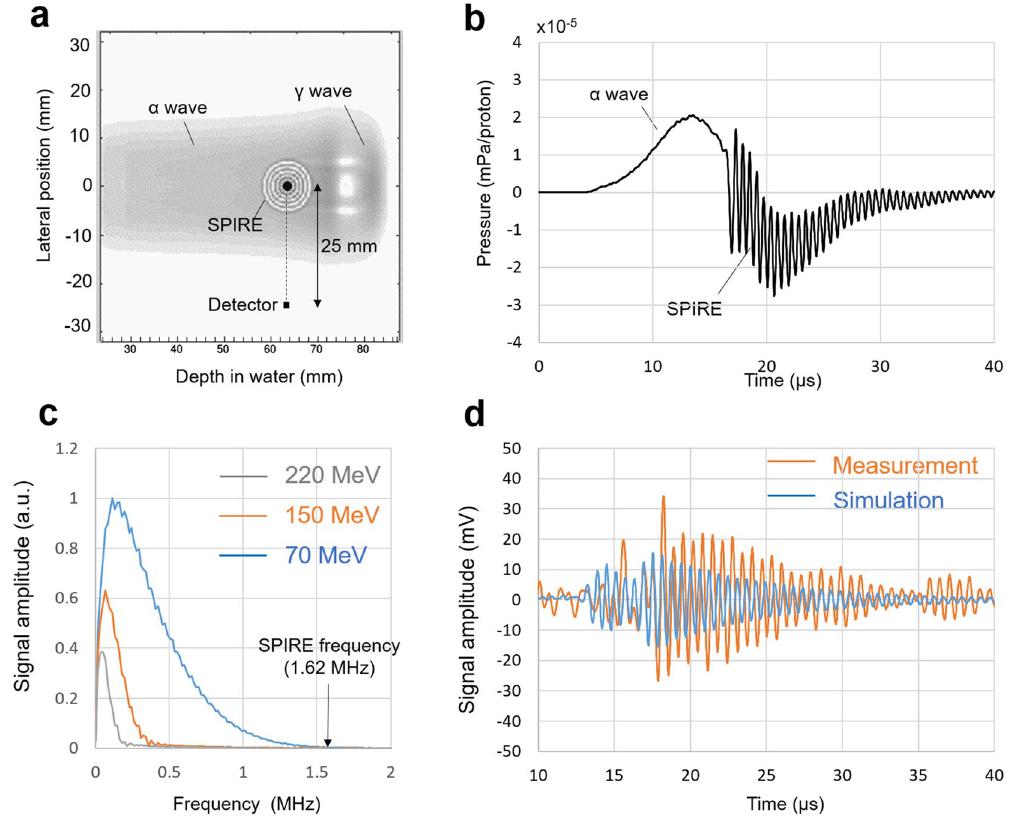
Figure 5. Simulations of the acoustic waves and comparisons with the measured waves. ( a ) Ionoacoustic wave propagation simulation showing three characteristic waves that appear after the beam injection: a wave from the plateau region of the Bragg curve (α-wave), a wave from the Bragg peak (γ-wave) and a SPIRE emitted from the marker. Higher pressure areas are shown in darker colours. The beam energy was 100 MeV (the beam range of 78.0 mm) and the beam spot size (1σ) at the surface of the water phantom was 4.9 and 5.7 mm in the vertical and horizontal directions, respectively. The beam pulse width (1 σ ) was set to 100 ns in this simulation. ( b ) The pressure waveform detected by a point virtual detector placed at 25 mm from the marker. The detector response was assumed not to depend on the frequency. The pressure amplitude of the α-wave was of the same order as that of the SPIRE. ( c ) The frequency spectra of the γ-waves detected by a point virtual detector placed on the beam axis at 20 mm downstream of the beam range. The simulation was performed with three proton energies (70, 150 and 220 MeV) used in clinical machines. The maximum frequency of the γ-waves was less than 1.5 MHz and thus the separation of the SPIRE from the γ-wave is always possible. ( d ) The measured and simulated SPIRE: the results are similar but an absolute difference in the pressure amplitude was observed. The simulated waveform was obtained after including the detector size effect and applying the amplified and bandpass-filtered frequency response of the V397-SU